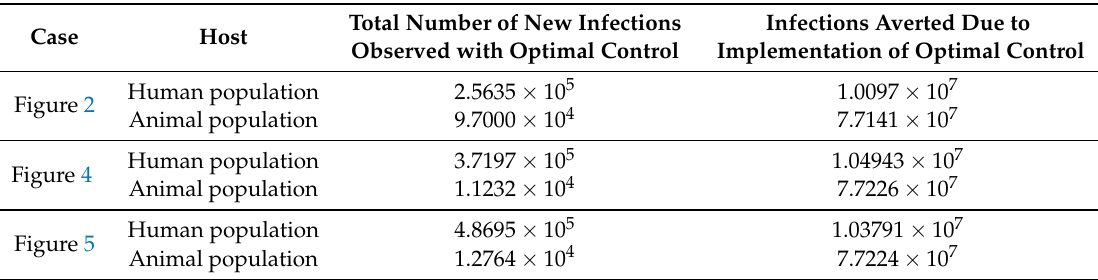
Table 3. Infection reduction due to the implementation of optimal